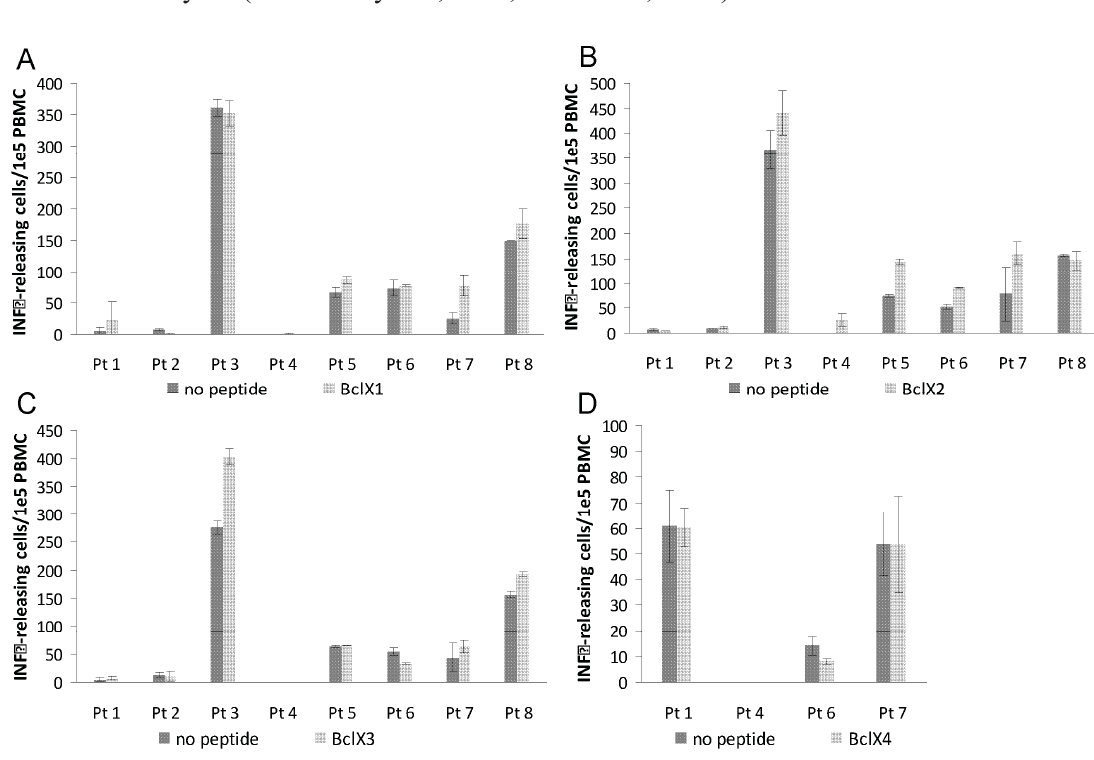
Figure 2. T-cell responses against Bcl-X(L) as measured by IFN- (cid:3) ELISPOT. PBMC from eight melanoma patients were analyzed. The peptides Bcl-X1(TAYQSFEQVVNELFR DGVNW) (A) , Bcl-X2 (VVNELFRDGVNWGRIVAFFS) (B) , Bcl-X3 (GVNWGRIVAFF SFGGALCVE) (C) , and Bcl-X4 (AFFSFGGALCVESVDKEMQV) (D) were examined. T-lymphocytes were stimulated once with peptide before being plated at 10 5 cells per well in duplicates either with or without peptide. The number of IFN- (cid:3) without ( dark grey ) or with ( light gray ) added peptide was calculated for each patient using the